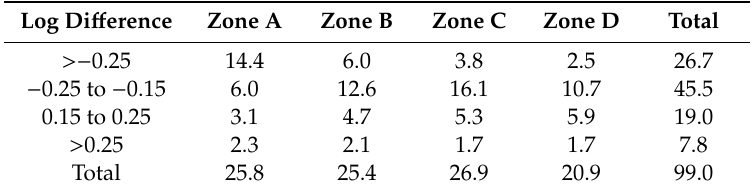
Table 5. Zonal statistics using the VV polarization for each log di ff erence threshold and zone (Zone A to Zone D). Areas are measured in hectares (10,000 m 2 ).